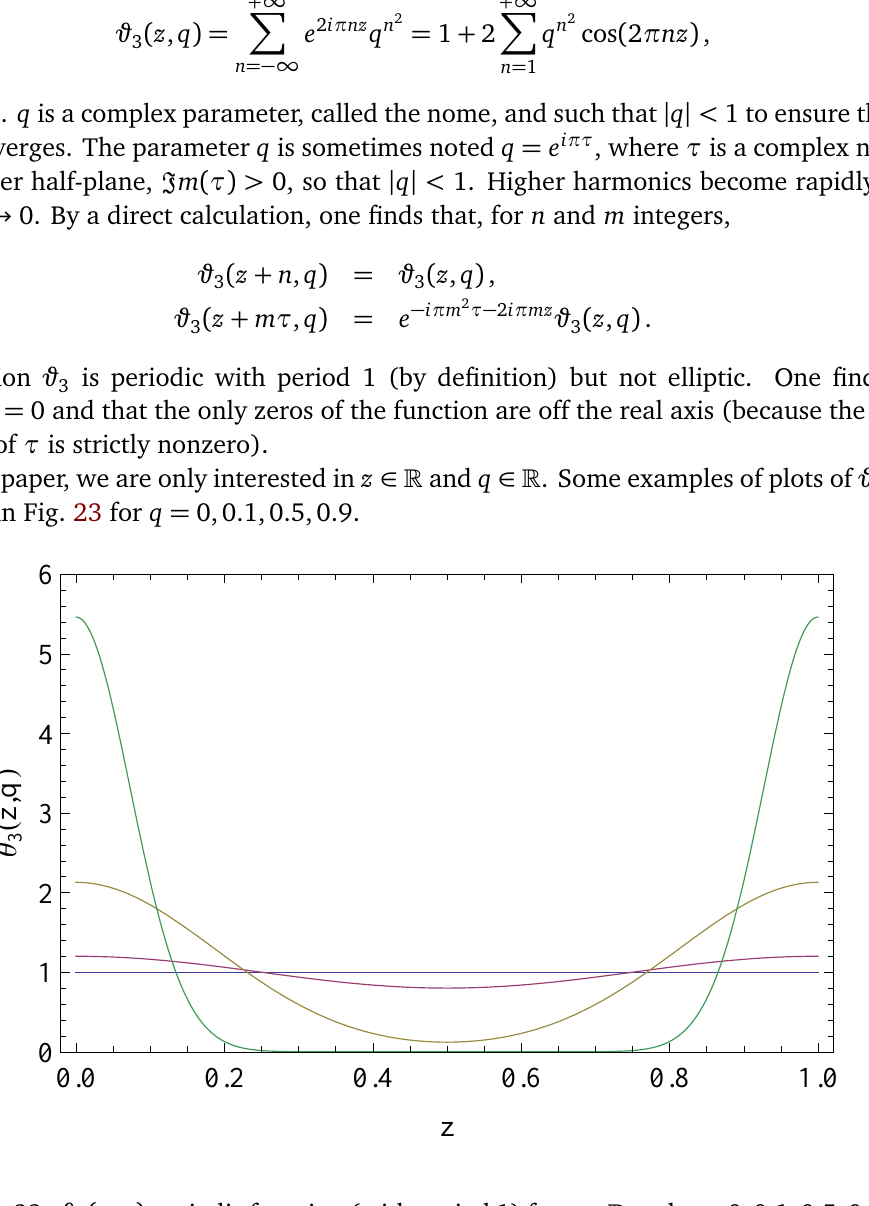
( z , q ) periodic function (with period 1) for z ∈ (cid:82) and q = Figure 23: ϑ 3